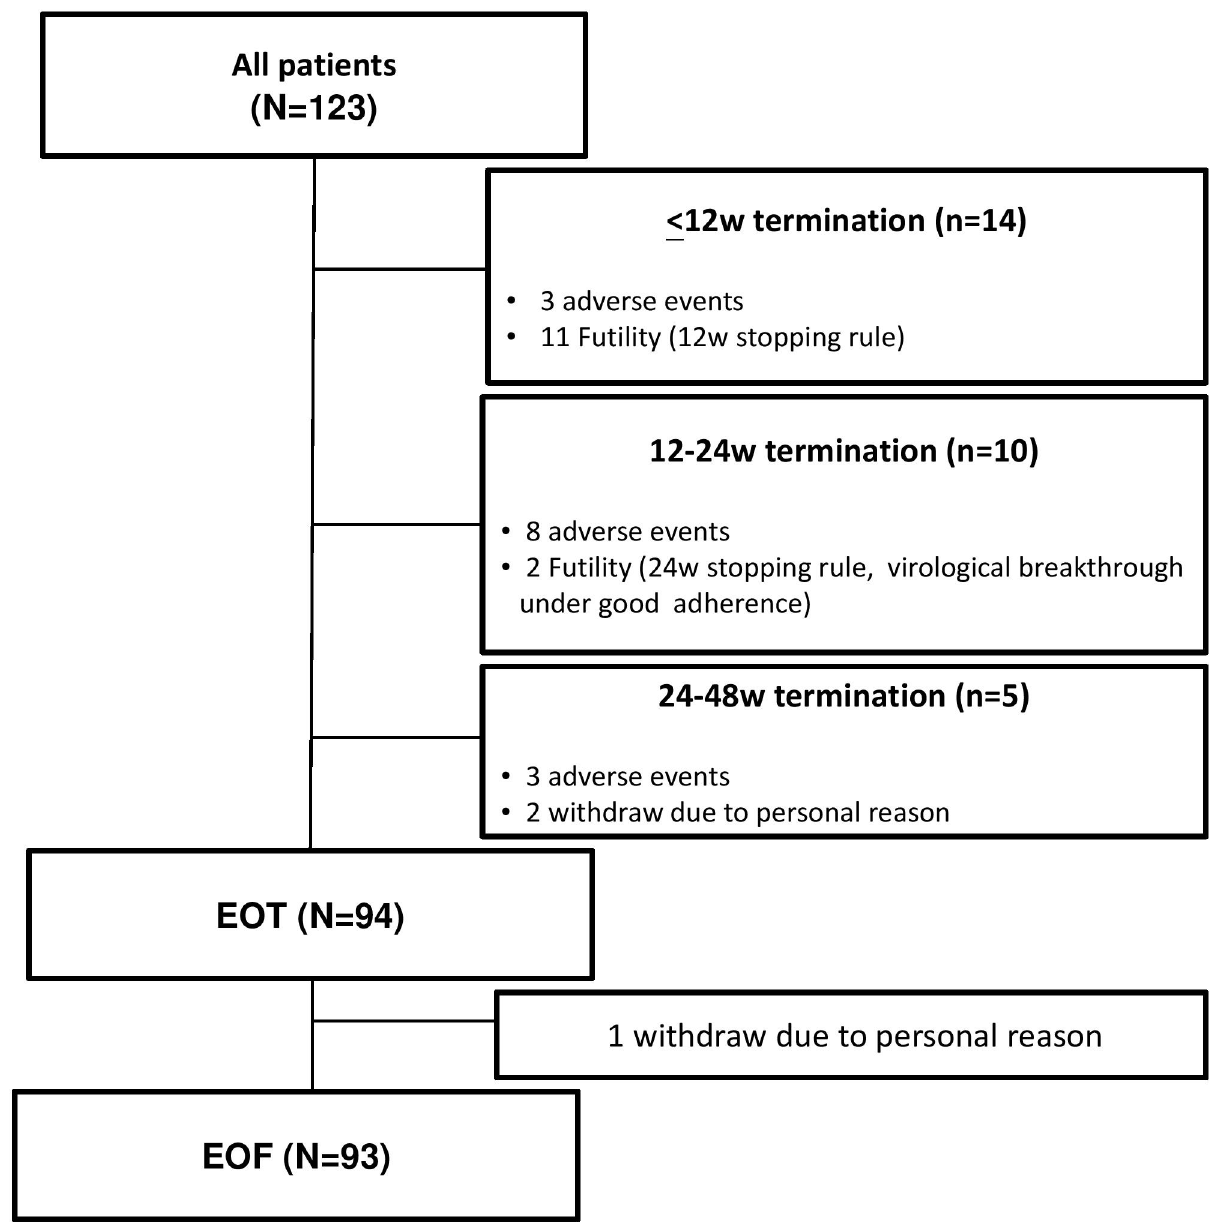
Fig 1. Study protocol. EOT: end of treatment. EOF: end of follow-up, defined as 24 weeks after stopping antiviral therapy.